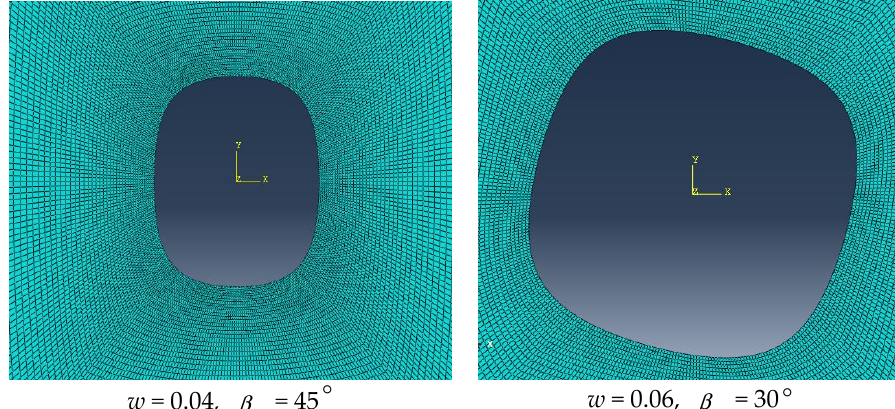
Figure 3. Mesh refinement for composite laminate containing rectangular hole.